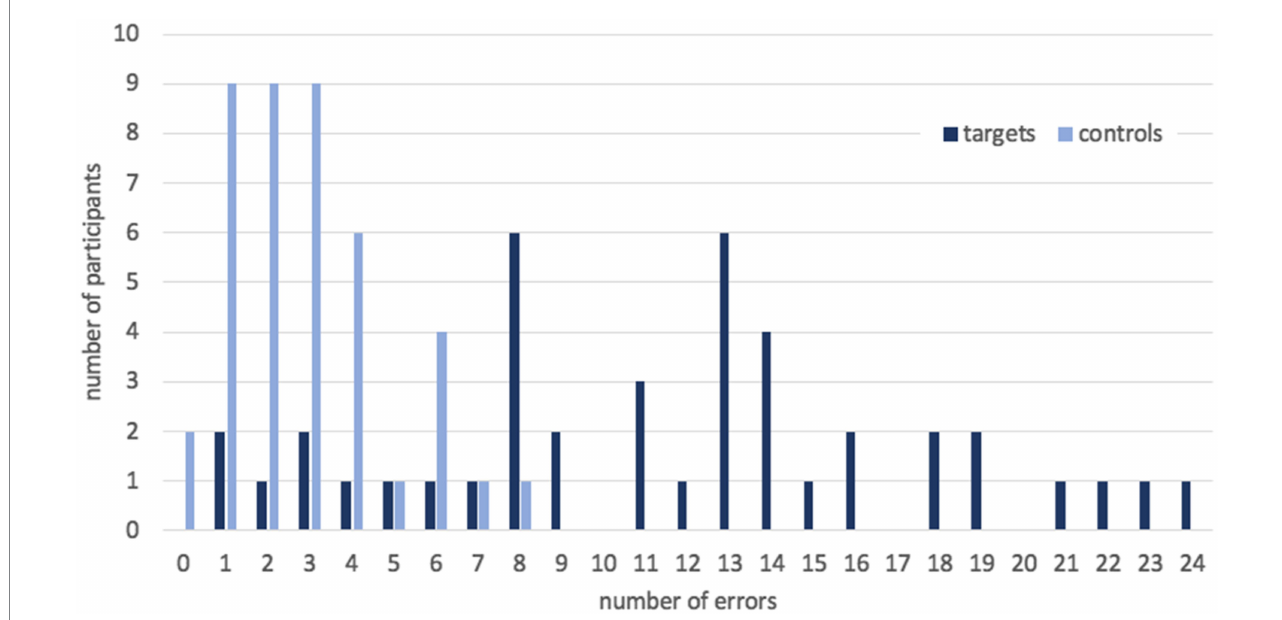
FIGURE 1 The number of errors per participant in target and control sentences in Experiment 1.